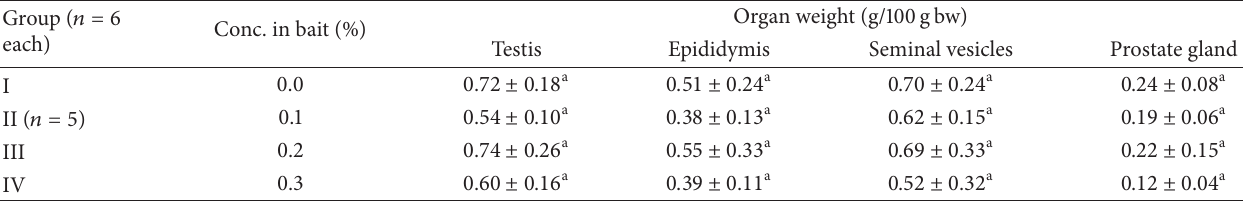
Values are mean ± SD; 𝑛 = number of rats; a mean values in a column sharing common superscript do not differ significantly ( 𝑃 ≤ 0.05 ).